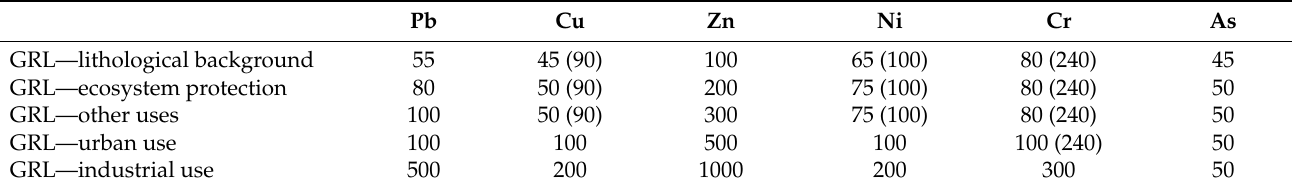
Table 2. Generic reference levels (GRL, in mg kg − 1 ) established for trace elements contents in Galician regulations for contaminated soils [32]. Lithological exceptions for basic rocks are indicated in brackets, when they are different from the general levels. Pb Cu